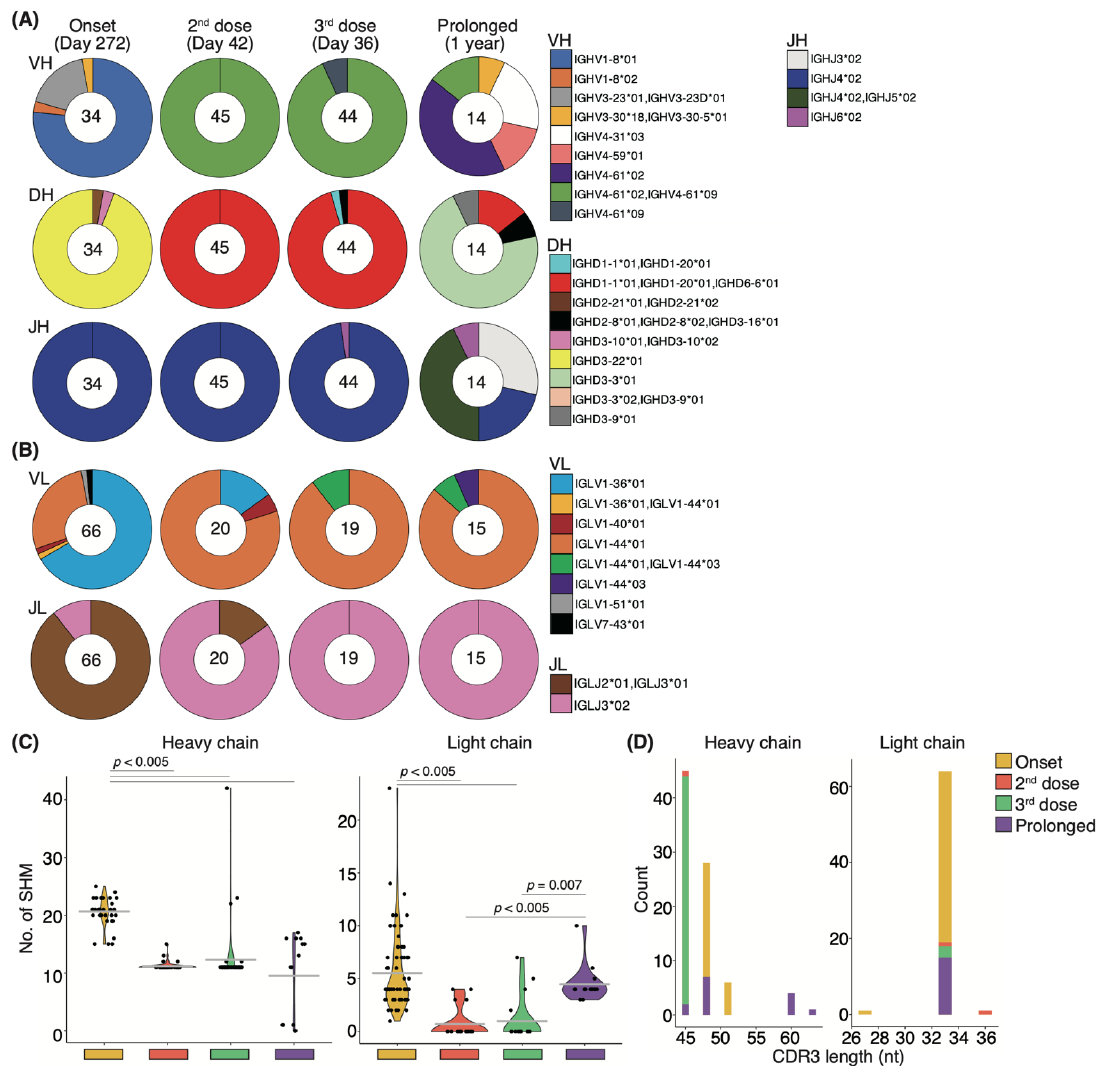
Figure 7. Affinity maturation of S-RBD-specific memory B-cells after vaccination: Pie charts show the distribution of heavy chain genes ( A ) and light chain genes ( B ) from onset to post-vaccination, comparing patients with the recovered individual ( n = 1) and a prolonged COVID-19 patient ( n = 1). The number in the inner circle indicates the number of sequenced clones. ( C ) Graphs show the number of somatic hypermutations in each antibody gene. Statistical significances were determined using Tukey – Kramer test. ( D ) Graphs show the distribution of CDR3 length in each antibody gene (heavy chains; n = 34 – 45 clones/recovered individual, 14 clones/prolonged COVID-19 patient; light chains; 18 – 66 clones/recovered individual, 15 clones/prolonged COVID-19 patient).